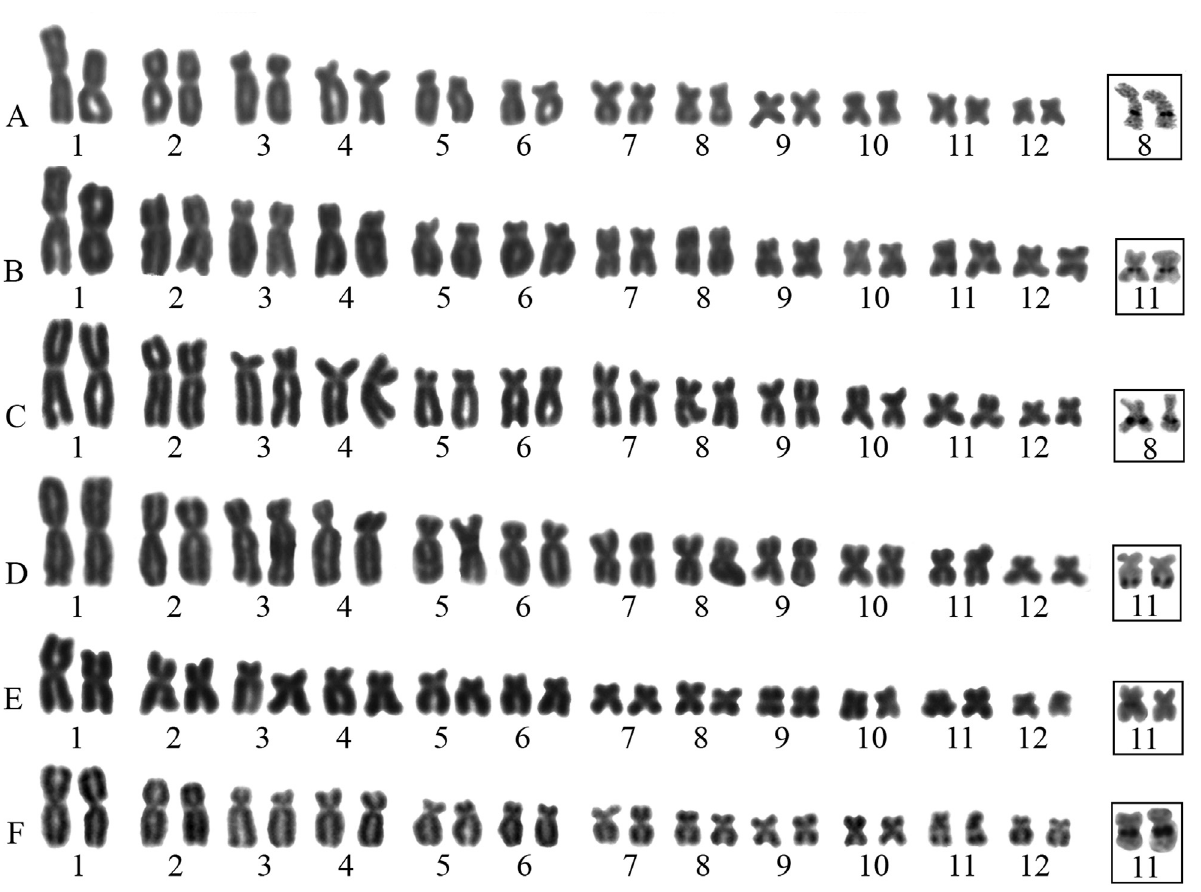
Figure 1 - Giemsa stained karyotypes of Scinax species: (A) S. boesemani , (B) S. camposseabrai , (C) S. garbei , (D) S. pachycrus , (E) S. trilineatus and (F) S. x-signatus . The NOR-bearing chromosomes after silver nitrate staining are highlighted in